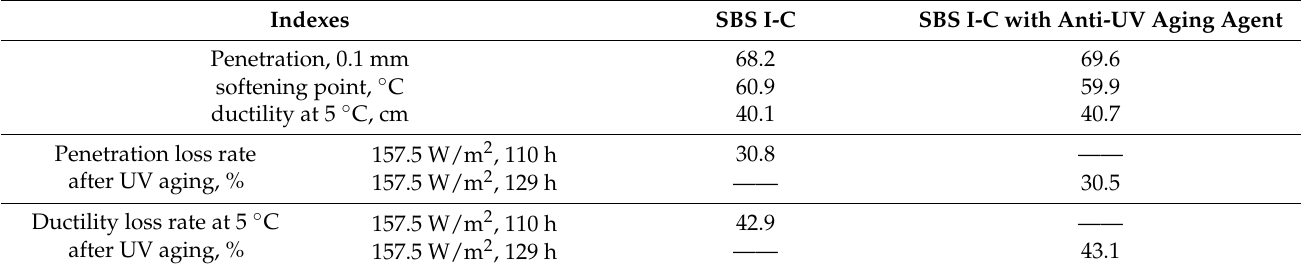
Table 7. The technical indexes of asphalt used in the trial sections.